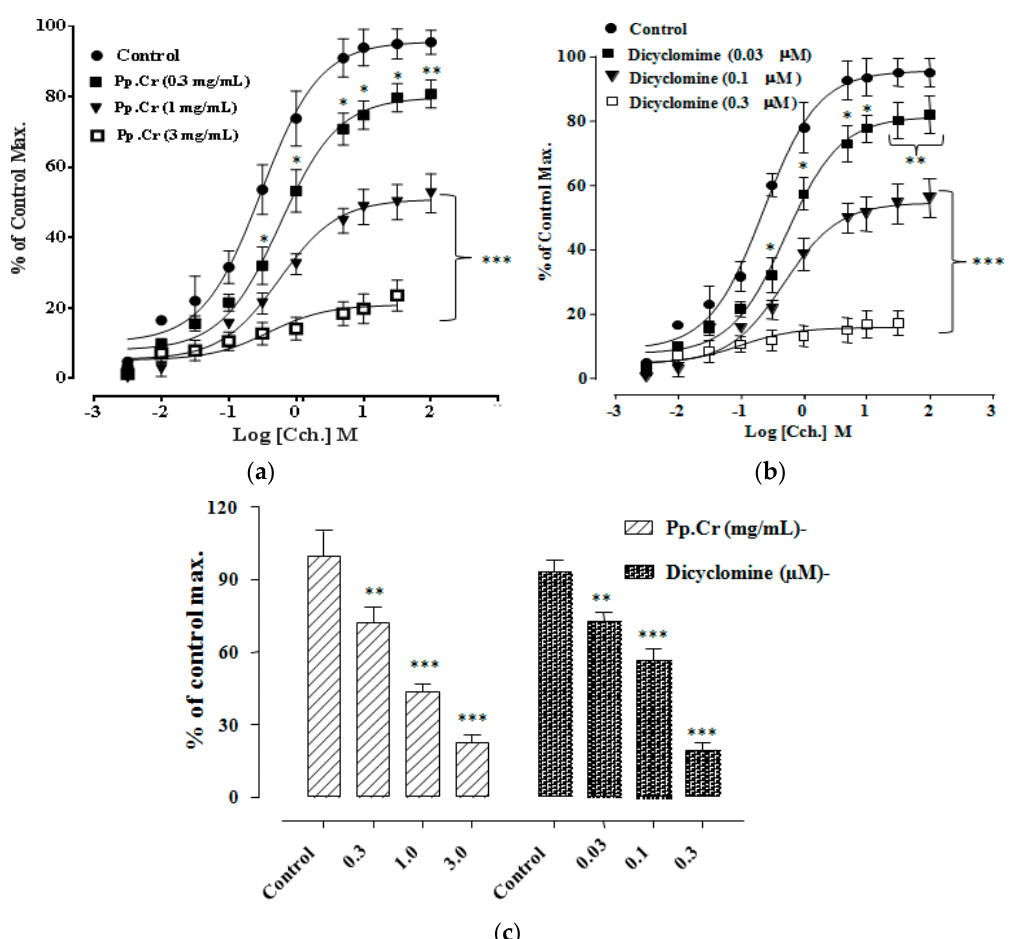
Figure 3. CRCs of Cch in the absence and presence of increasing conc. of Pp.Cr (mg/mL) ( a ) and dicyclomine (µM) on jejunum preparations ( b ) Statistical graph comparing CRCs of Cch in the absence and presence of Pp.Cr (mg/mL) and dicyclomine (µM) on jejunum preparations ( c ) * p < 0.05, ** p < 0.01, *** p < 0.001 compared to the respective control. (Mean ± SEM, n = 3).